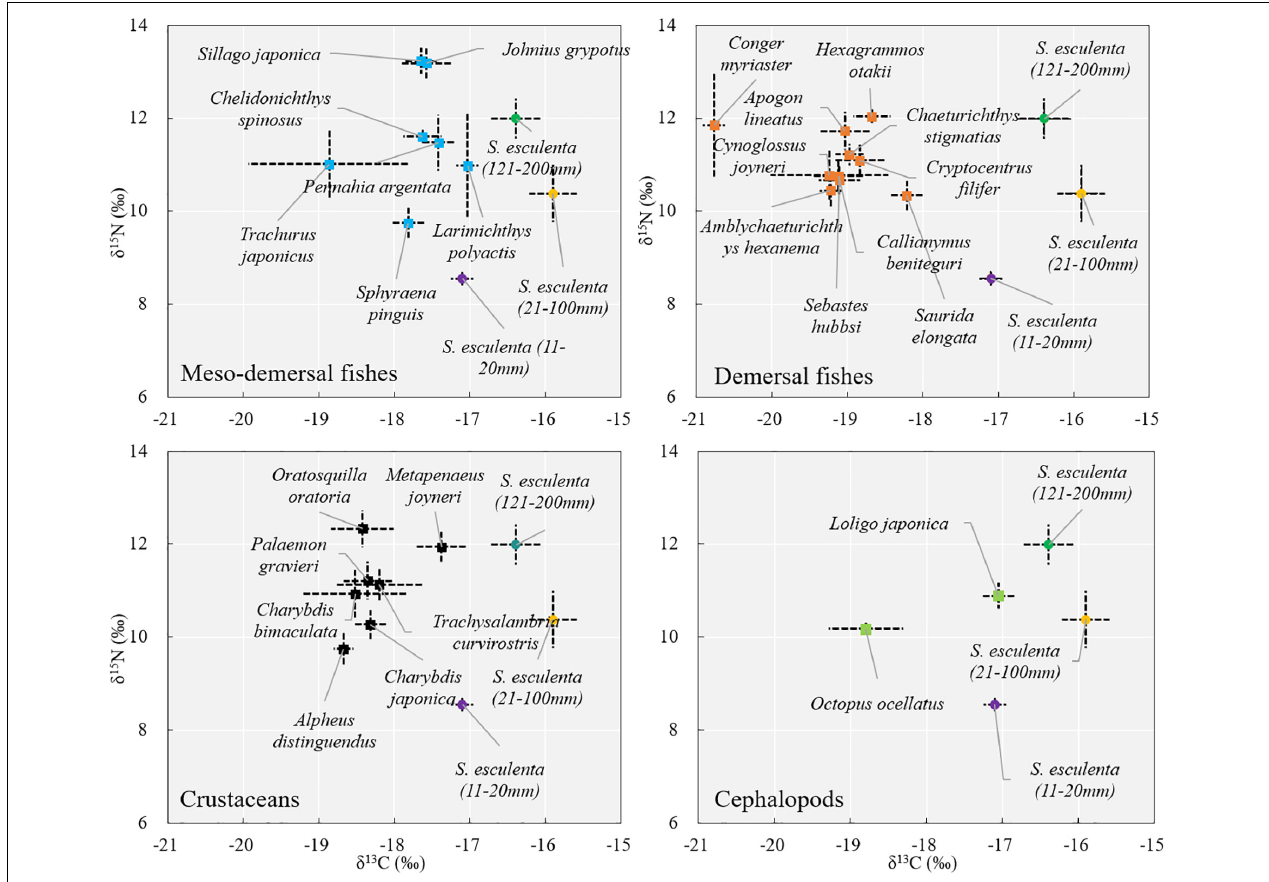
FIGURE 4 | Biplot of the isotopic values (mean ± SD) of all the samples.